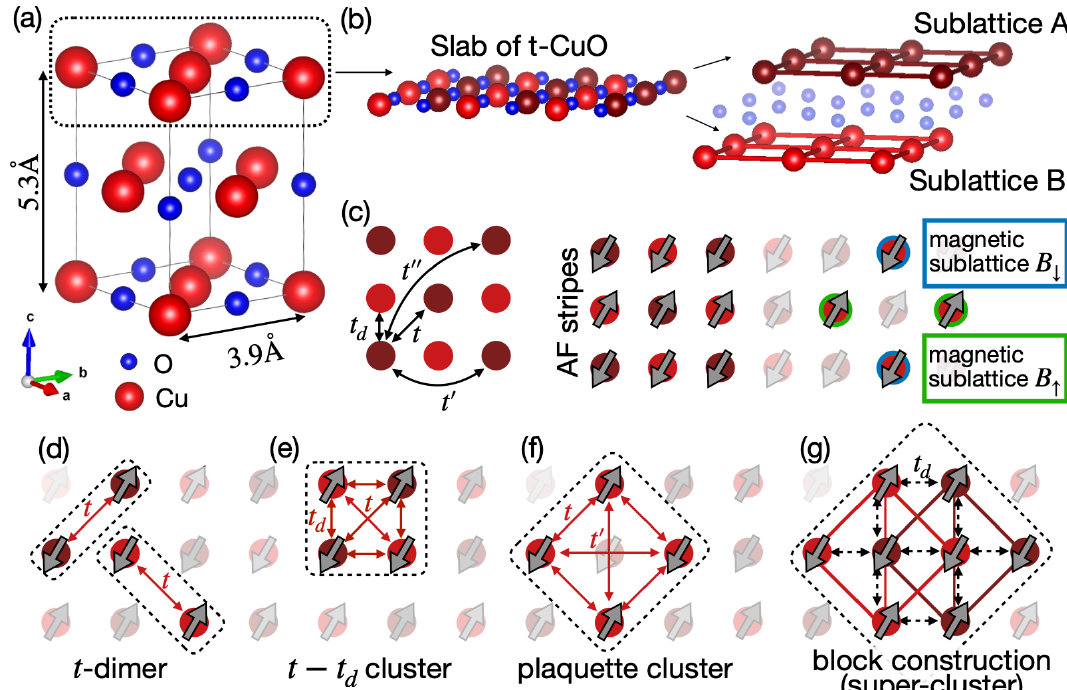
Figure 1: (a) Rock salt crystal structure of tetragonal CuO. (b) slab of CuO within the a-b plane. Bright (dark) red atoms indicate the sublattice A and B of our model. (c) Two identical Cu-sublattices and indication of the hoppings t , t , t ′ and t ′′ included d in the model. The arrows sketch the columnar magnetic order corresponding to an ordering vector Q = ( 0, π ) considered throughout the paper. Highlighted in blue and green are the magnetic sublattices that correspond to this ordering. (d-g) Clusters including different hopping terms as discussed in the